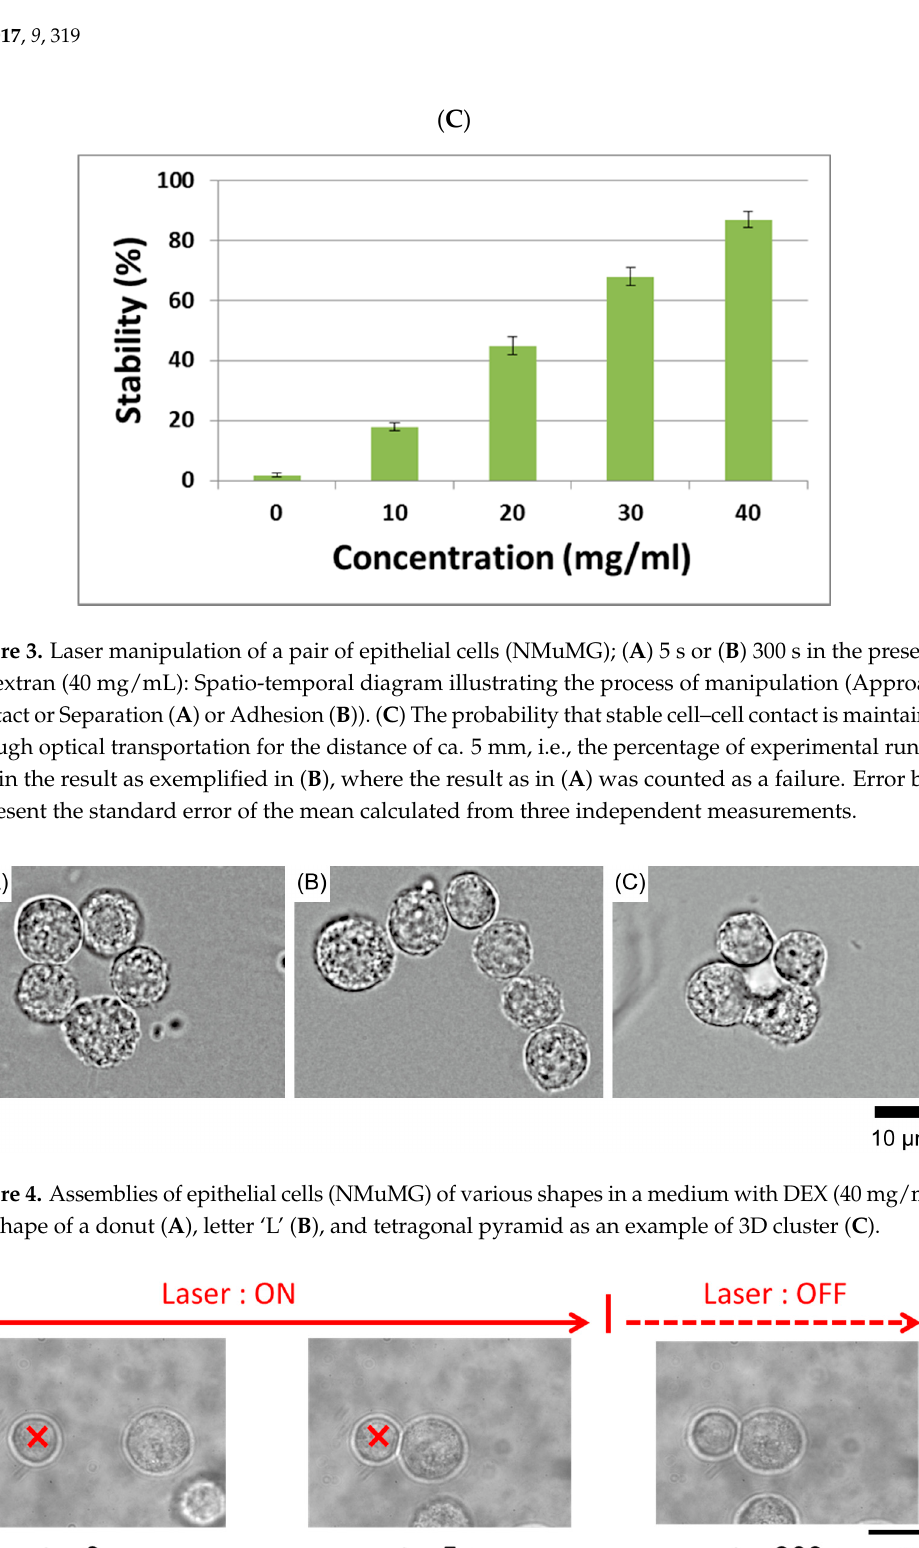
Figure 5. Stable cellular assembly of Neuro2A cells in a dextran (50 mg/mL) medium using optical laser tweezers. The focal point of the laser is marked by the red ‘x’.